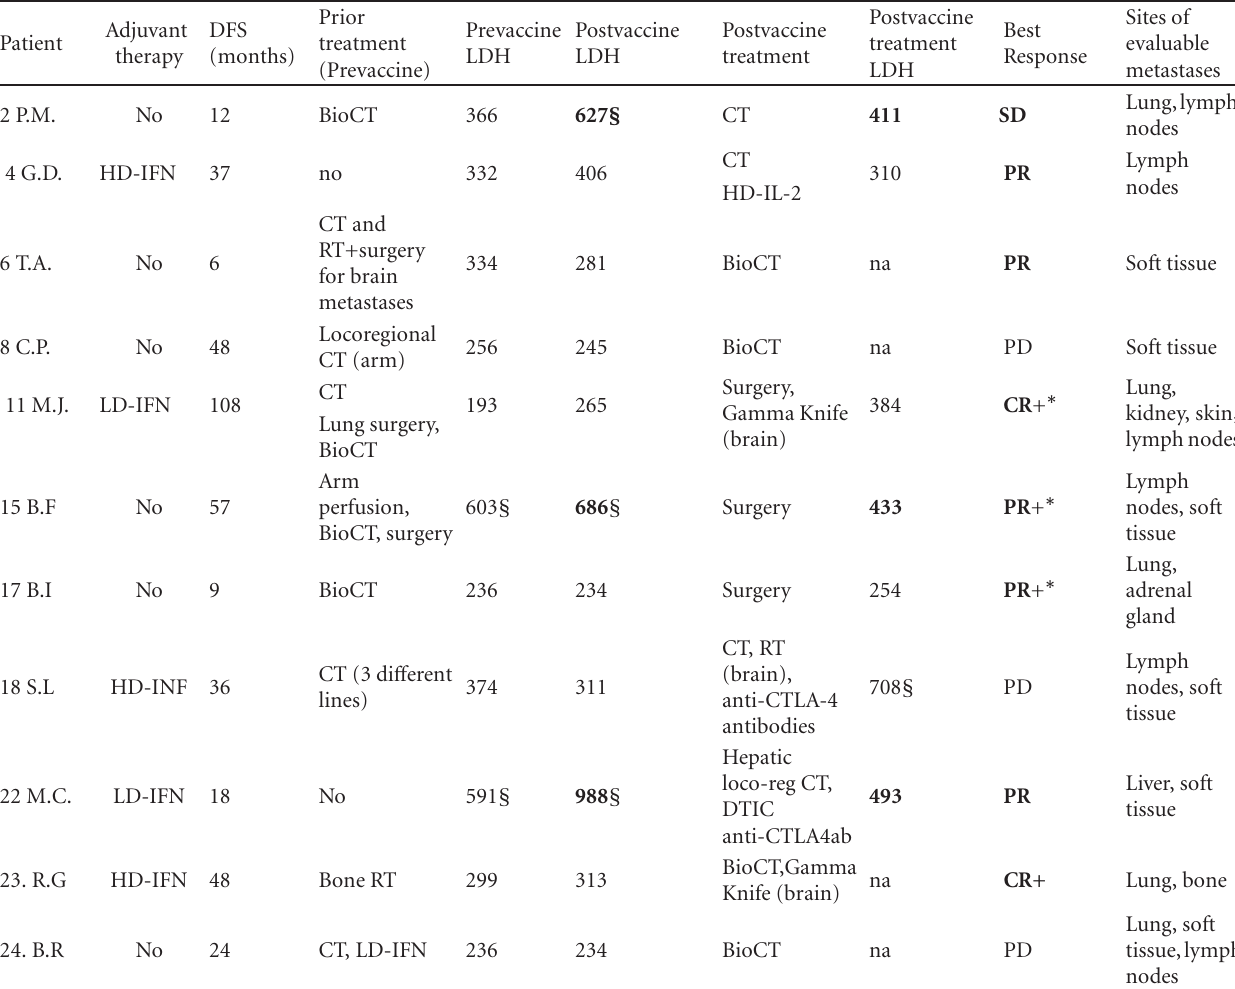
Table 1: Patients who underwent subsequent therapies after